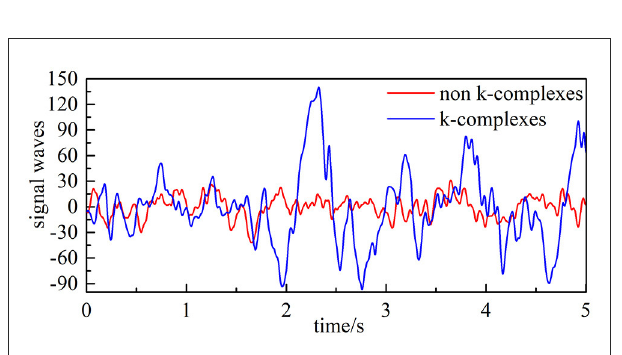
FIGURE2 Filtered EEG signal (the blue line is EEG signals with k-complex, and the red line represents EEG signals with